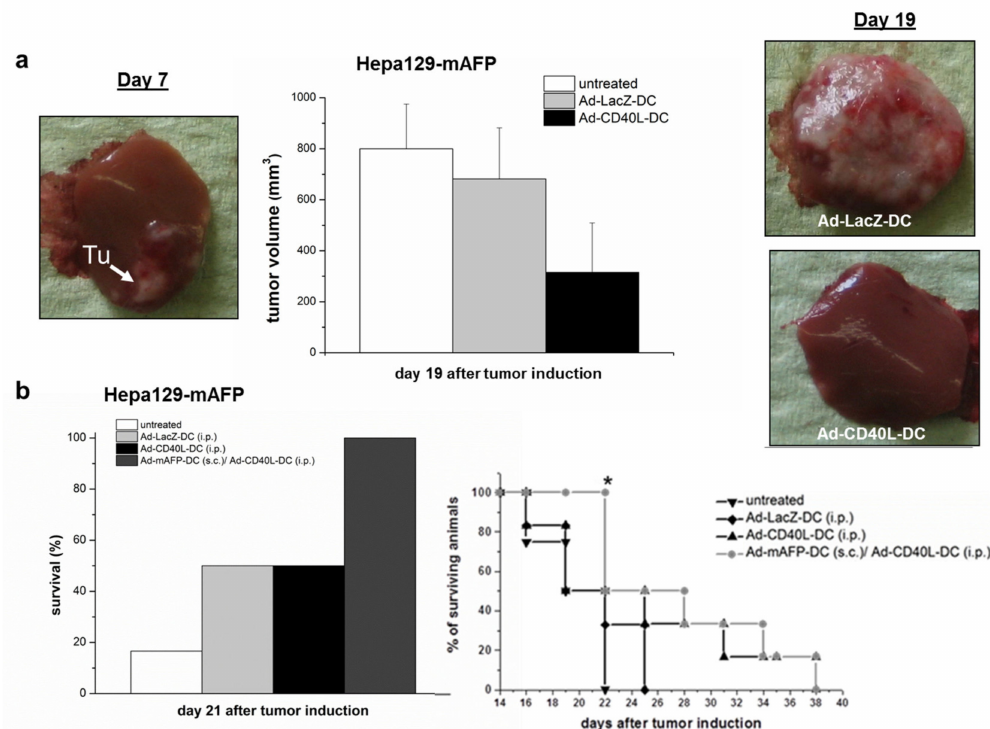
Figure 3. Antitumor effects in pre-established orthotopic HCC. ( a ) Tumor volume of orthotopic HCC after i.p.-treatment with 10 6 Ad-CD40L-DC 19 days after tumor induction (middle). Data are presented as mean tumor volume ± SD, ( n = 6 each group). Left: representative tumor at day 7 after tumor induction (before treatment). Right: representative tumors 19 days after tumor induction (12 days after DC-treatment). ( b ) Left: Survival rates of mice bearing orthotopic tumors after treatment with heterotopic DC-injection at day 21 ( n = 6 each group) Right. The lines marked with circles, triangles or squares were chosen to distinguish different treatments and represent time-points. Kaplan-Maier survival curve. Significance was determined using the log-rank